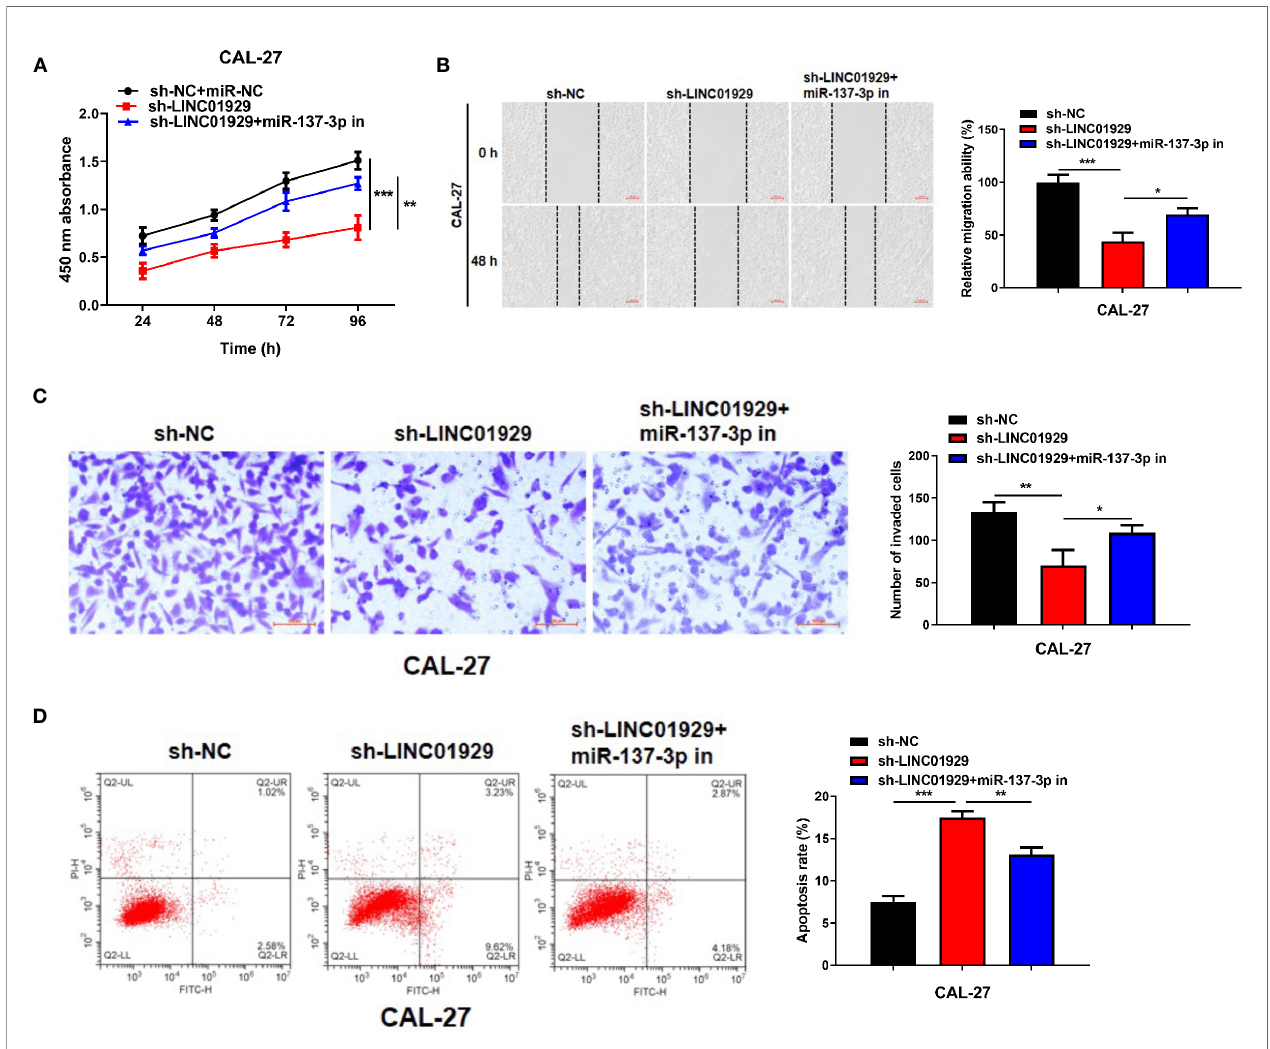
FIGURE 4 | MiR-137-3p inhibitor restored the effect of LINC01929 knockdown on OSCC cells. (A) CCK-8 assay showed CAL-27 cells proliferation after transfection of sh-NC, sh-LINC01929 and sh-LINC01929+miR-137-3p inhibitor. (B, C) Wound healing assay and transwell assay showed CAL-27 cells migration and invasion after transfection of sh-NC, sh-LINC01929 and sh-LINC01929+miR-137-3p inhibitor. (D) The fl ow cytometry was applied to measure apoptosis in each